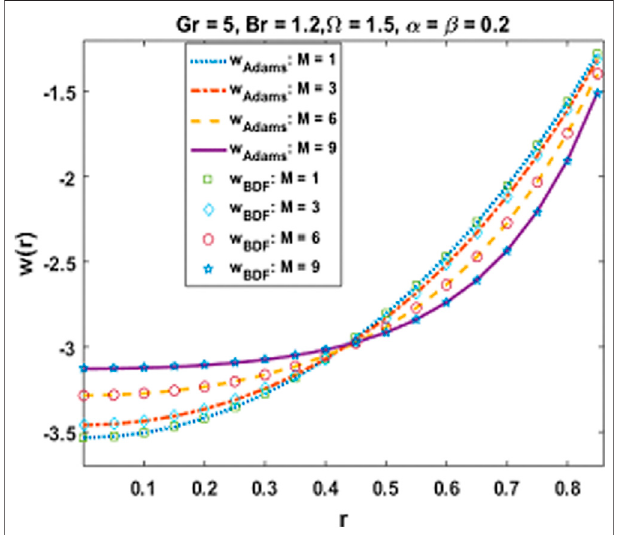
FIGURE 7 | Behavior of axial velocity against magnetic parameter.